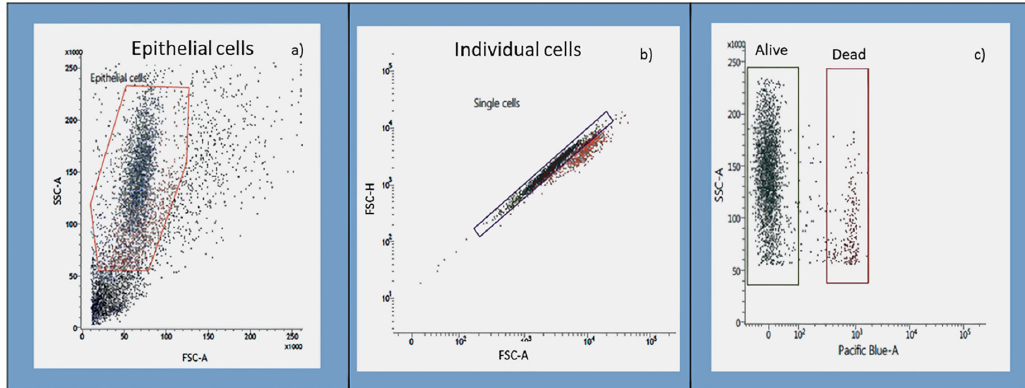
Figure 1. Gating strategy used to select the population of interest using a FACS Verse cytometer. ( a ) Nasal epithelial cells were selected by side scatter characteristic (SSC) and forward scatter characteristic (FSC) density plots. ( b ) A gate was applied to identify specific populations of individual cells. Each dot represents one nasal epithelial cell that passed through the cytometer laser. ( c ) Dead cells were identified and excluded from further analysis using either DAPI or PI.